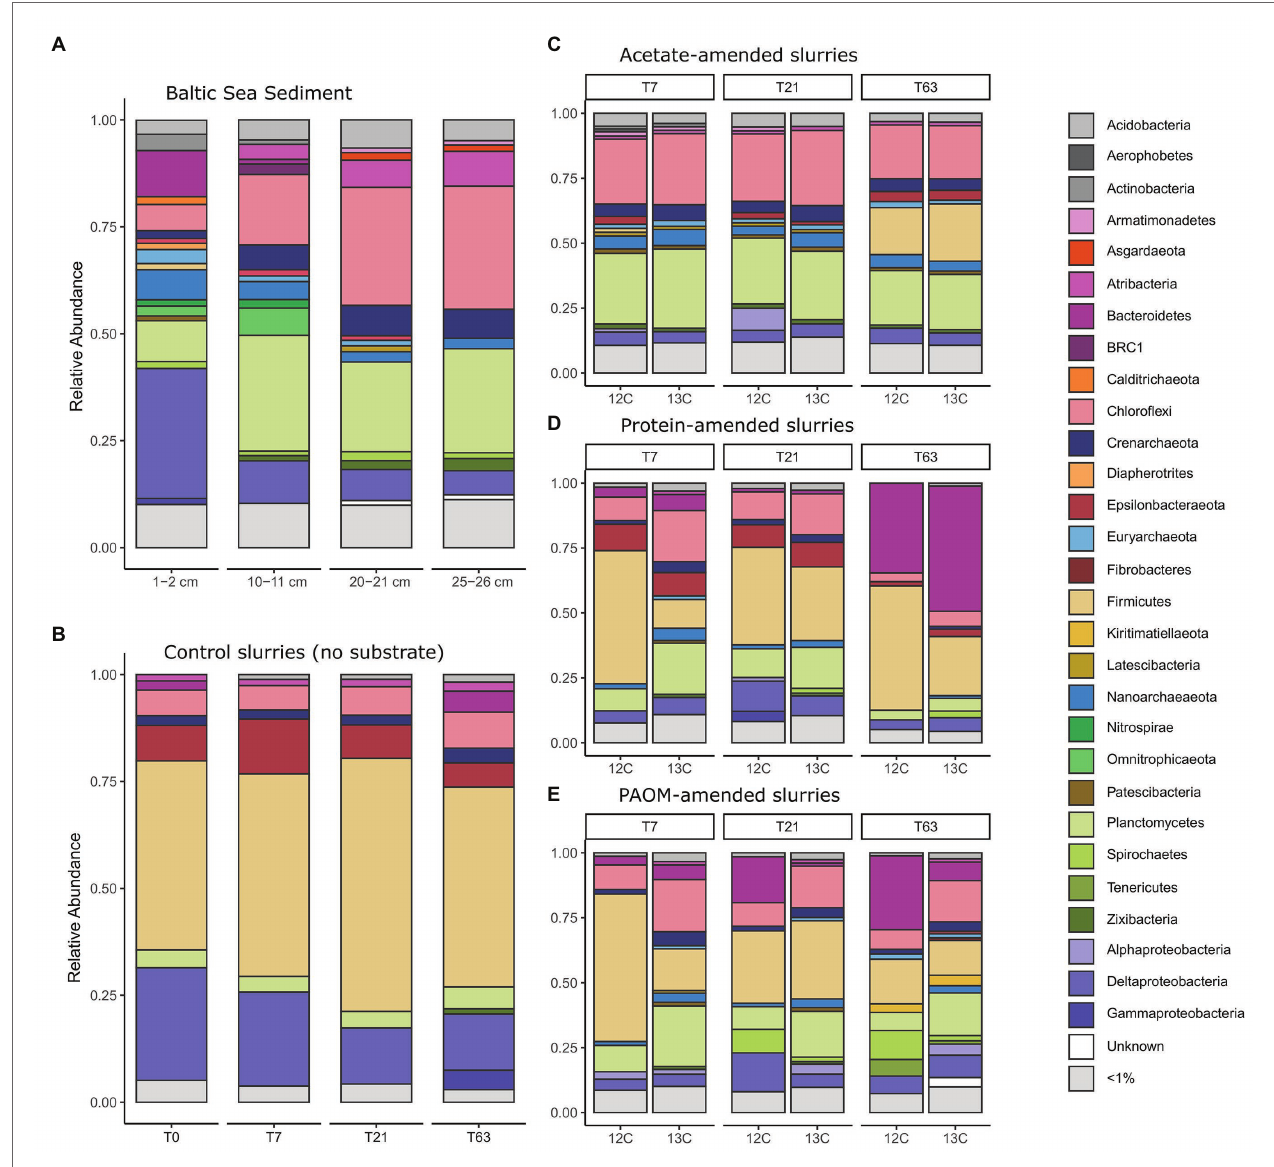
FIGURE 2 | Taxonomic composition of the 16S rRNA gene diversity across depth in the original sediment samples (A) and across time in constructed sediment slurries (B–E) with (B) the unamended sediment slurries, the sediment slurries amended with (C) acetate, (D) protein and, (E) particulate algal organic matter (PAOM). The total microbial community composition is shown for both unlabeled (marked 12 C) and labeled substrate (marked 13 C) slurries for (C–E) and by combining all the DNA stable isotope probing (DNA-SIP) fractions. Colors correspond to Class level taxonomy for Proteobacteria and phylum level taxonomy for all other